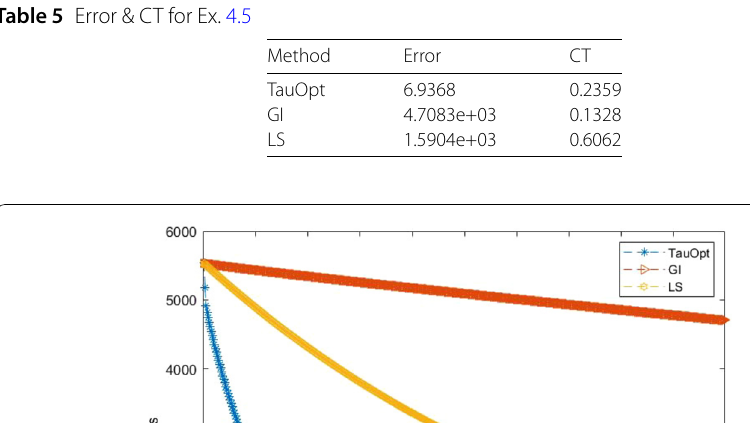
Table 5 Error & CT for Ex. 4.5